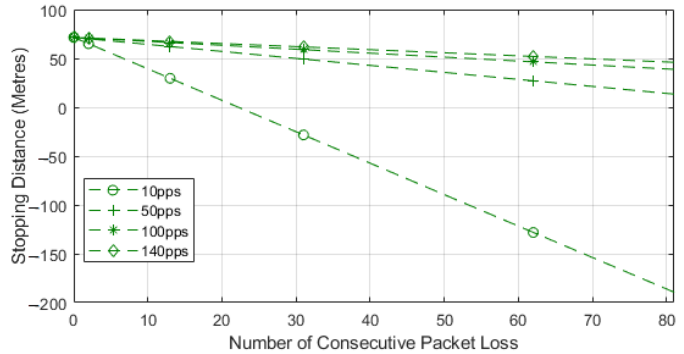
Figure 18. Seventy miles per hour (112.63 km/h) reduction in stopping distance.